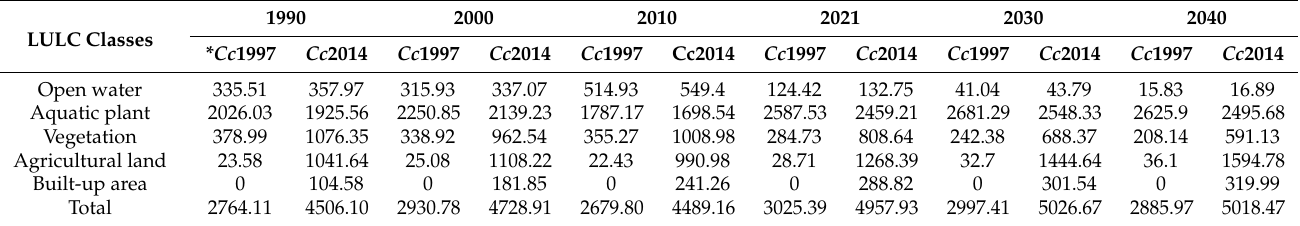
Table 7. Various LULC types’ provided ESV in 10 3 USD from 1990 to